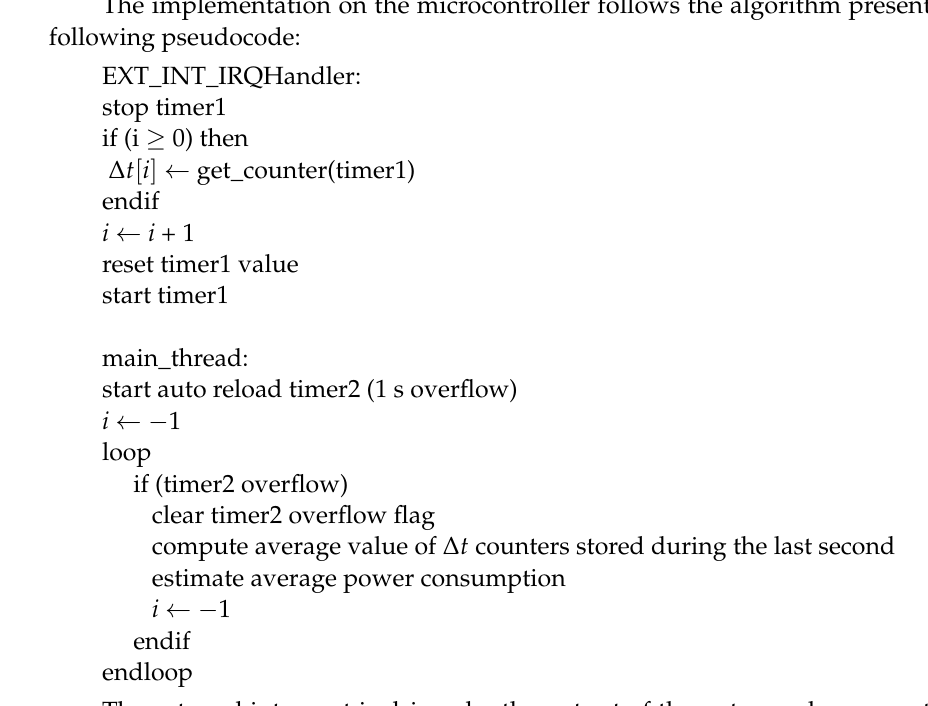
Figure 13. Interfacing board prototype.